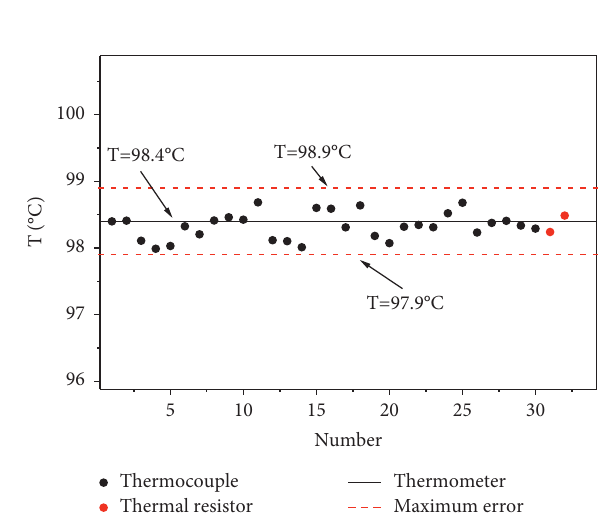
Figure 3: Thermocouple